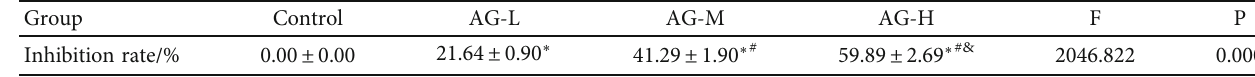
Table 2: Impacts of Amarogentin (AG) on HGC-27 multiplication, migration and apoptosis ( (cid:1) x ± s , n = 9 ). Group Control